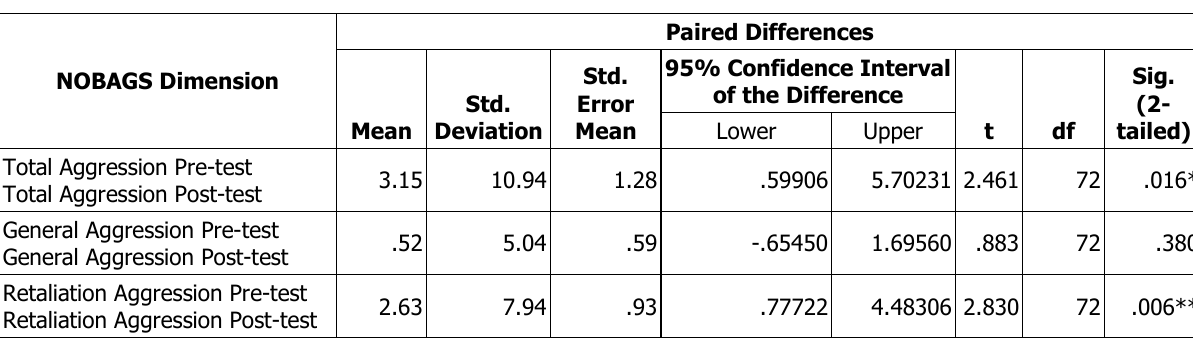
Paired Samples T-tests - Comparison Group's Pre-/Post-test NOBAGS Scores